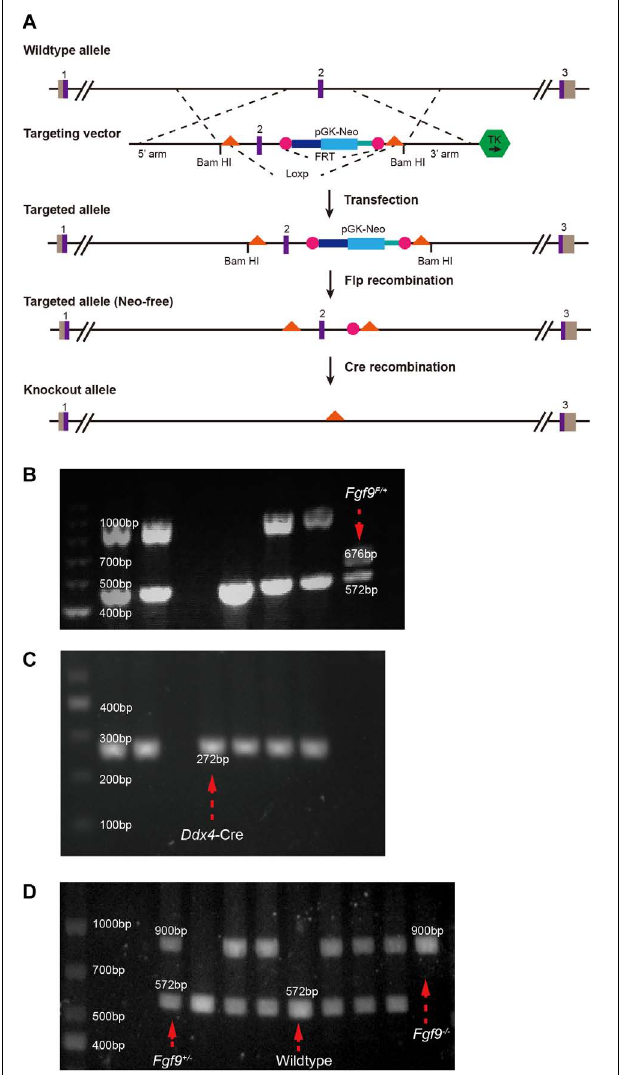
FIGURE 1 | Generation of Fgf9 knockout allele. (A) Generations of Fgf9 allele lacking exon 2. Purple boxes, exons. Gray boxes, introns. Orange triangles, loxP sites. pGK-NEO, pGK-NEO cassette for positive selection. TK, thymidine kinase cassette included for negative selection. PCR-based genotyping of (B) Fgf9 F / + (F indicates a floxed allele), (C) Ddx4–Cre , (D) Fgf9 + / − , Wildtype , and Fgf9 − / −